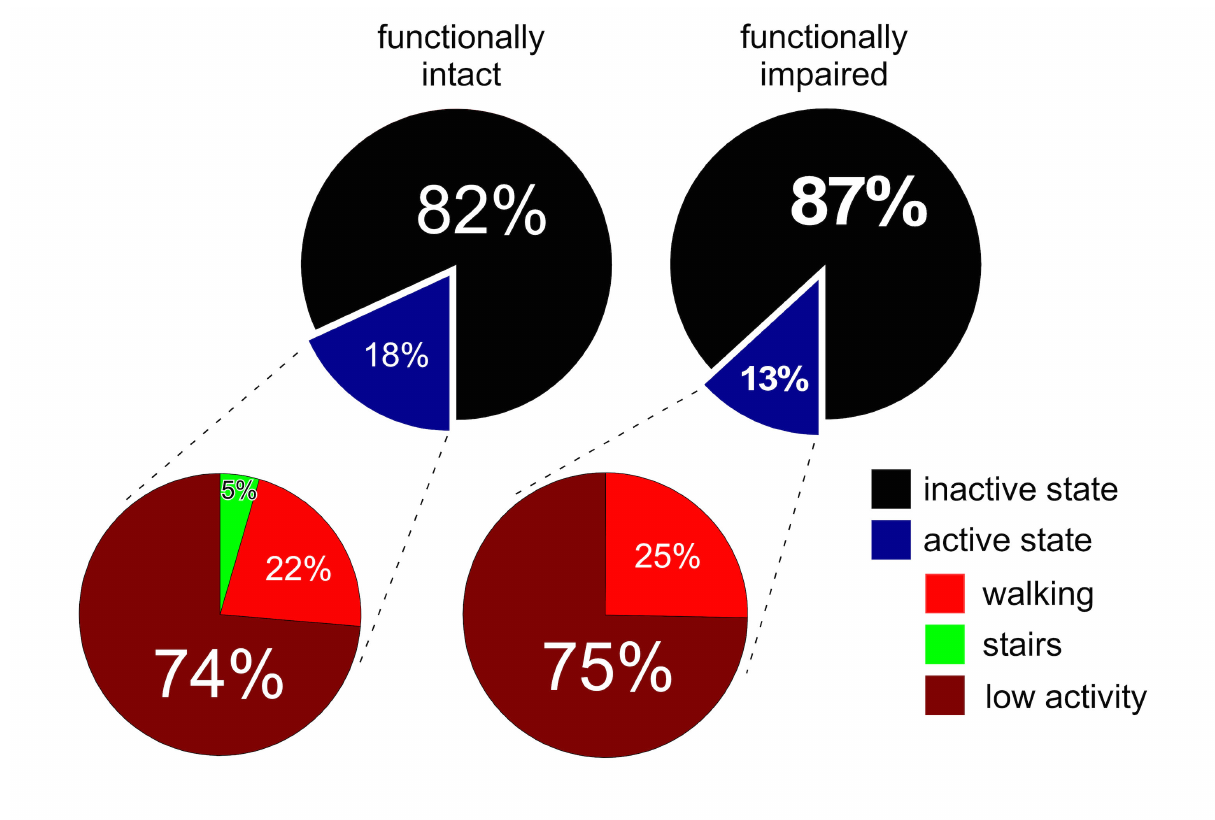
Figure 2. Mobile phone-derived activity metrics discriminate between frail and functionally-intact individuals. 24-hour time budget for functionallyintact (left) and functionally impaired (right) participants. Time spent in active state (blue slices) is further broken down into periods of low (brown)and high (red, green) physical activity. Percentages (bold) statistically differ between